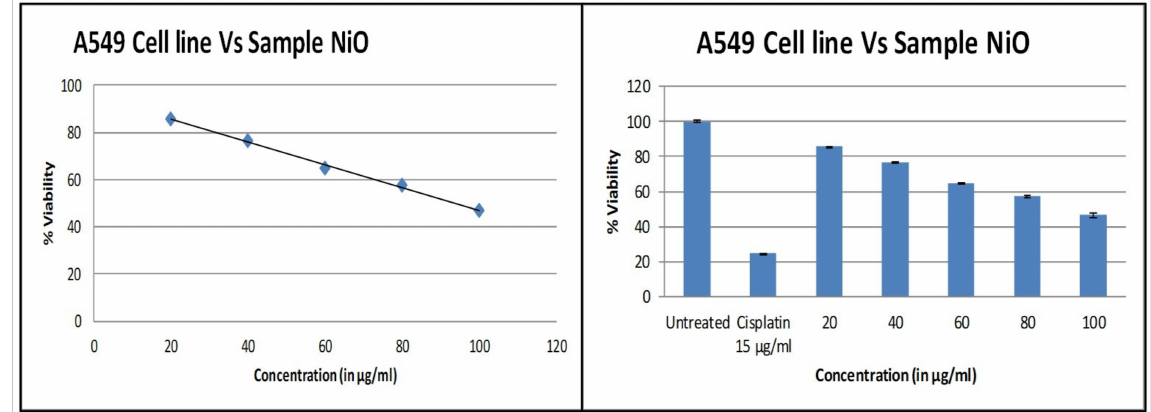
Figure 7. Graph representing the screening of anticancer activity with respect to the standard control for different concentra- tions of synthesized NiO